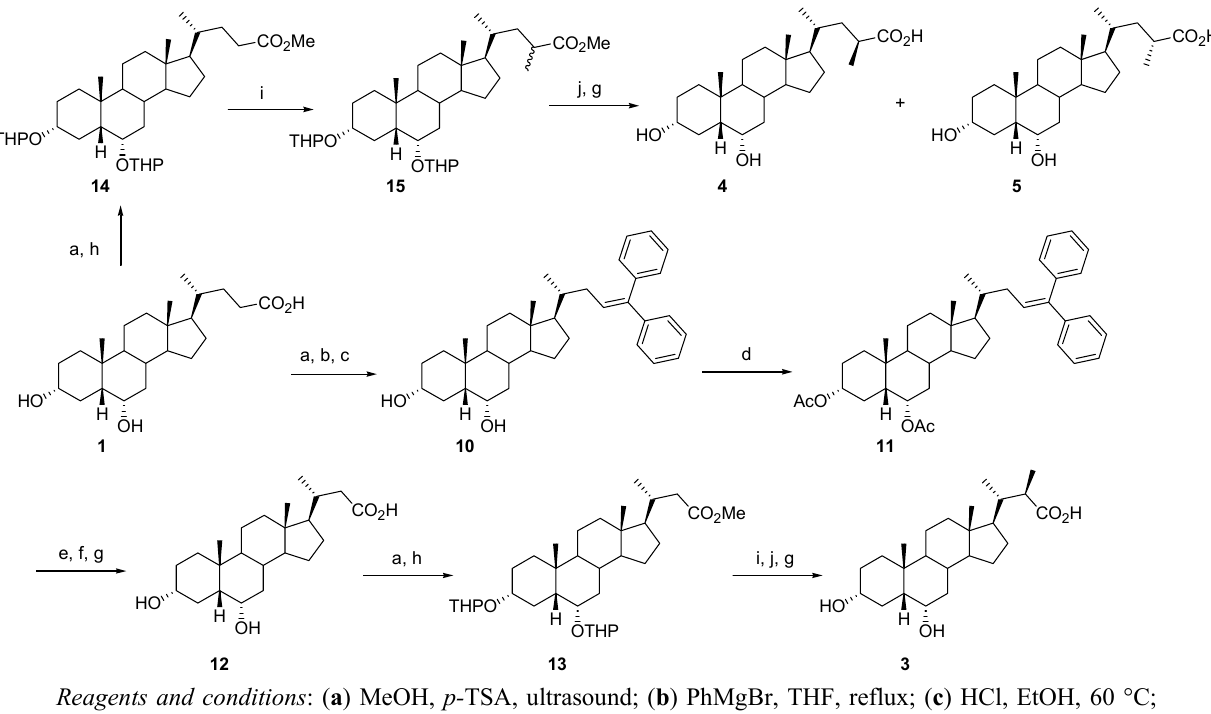
Scheme 2. Synthesis of C